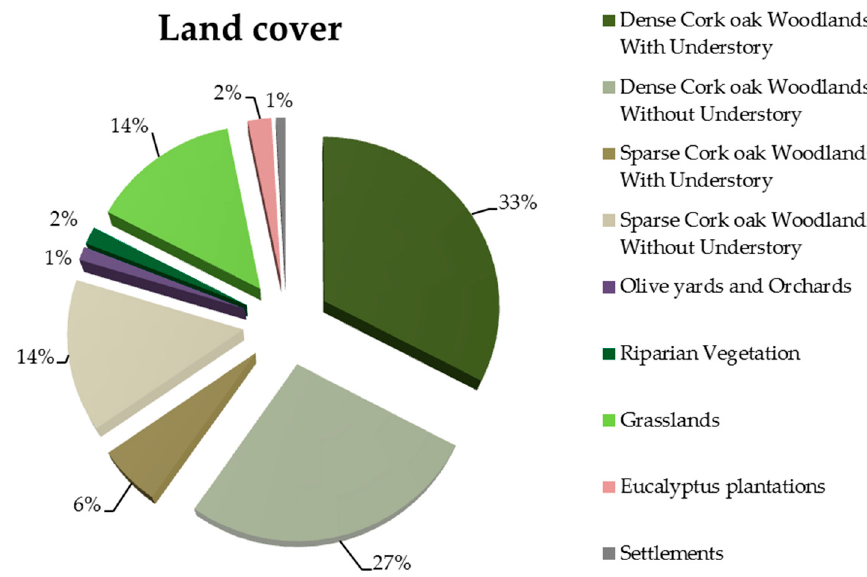
Figure 2. Photo-interpreted land-cover types and respective extent in the study area.